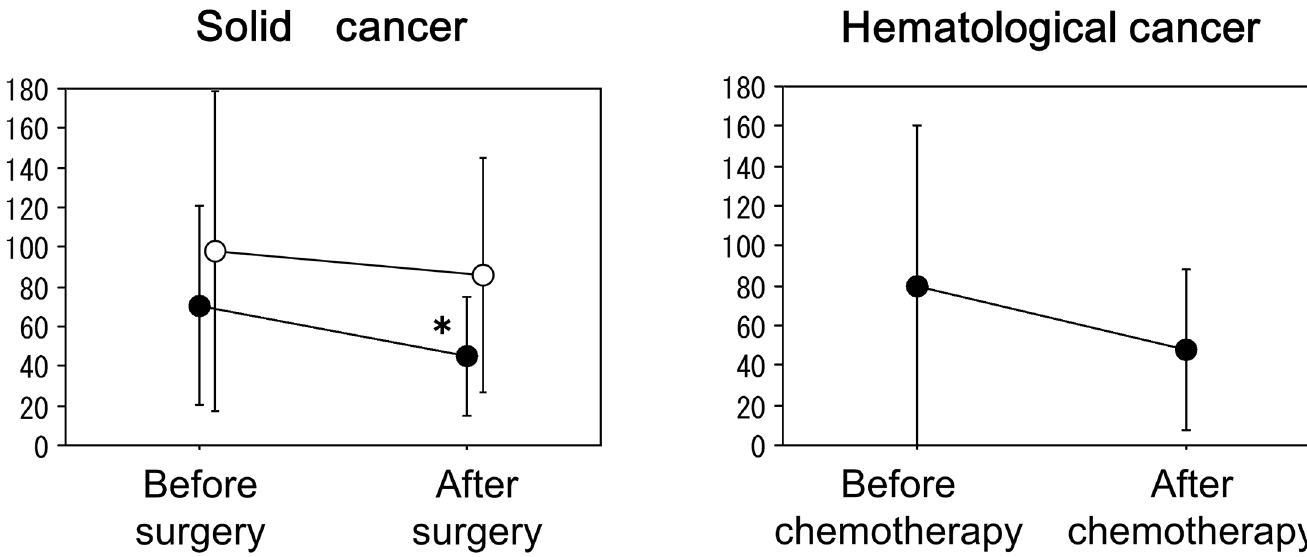
Fig 6. In 28 cured patients with solid cancerswho underwent a radical surgery, the plasma BNP levels significantly decreased after the surgery (left panel, closed circles) ( * p < 0.01vs the value before surgery). On the other hand, in 7 relapsed or insufficiently treated patients with solid cancers, the plasma BNP levels did not change after the surgery (left panel, open circles). In 13 patients with hematological cancers, the plasma BNP levels tended to decreaseafter the chemotherapy, but it did not reach a statistical